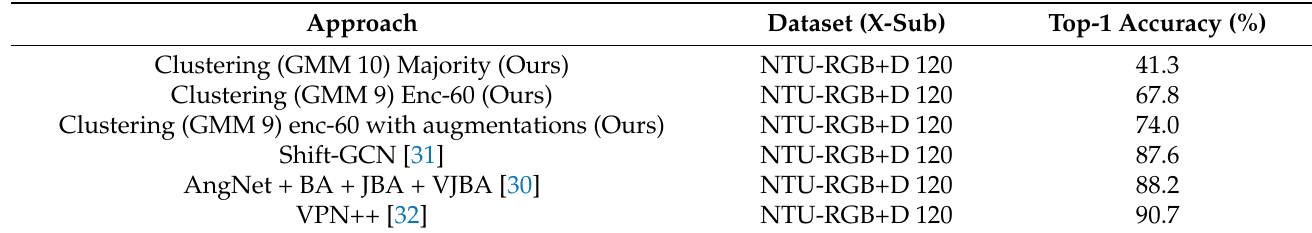
Table 13. Comparison of the proposed approach with state of the art methods (NTU-RGB+D 120 dataset).